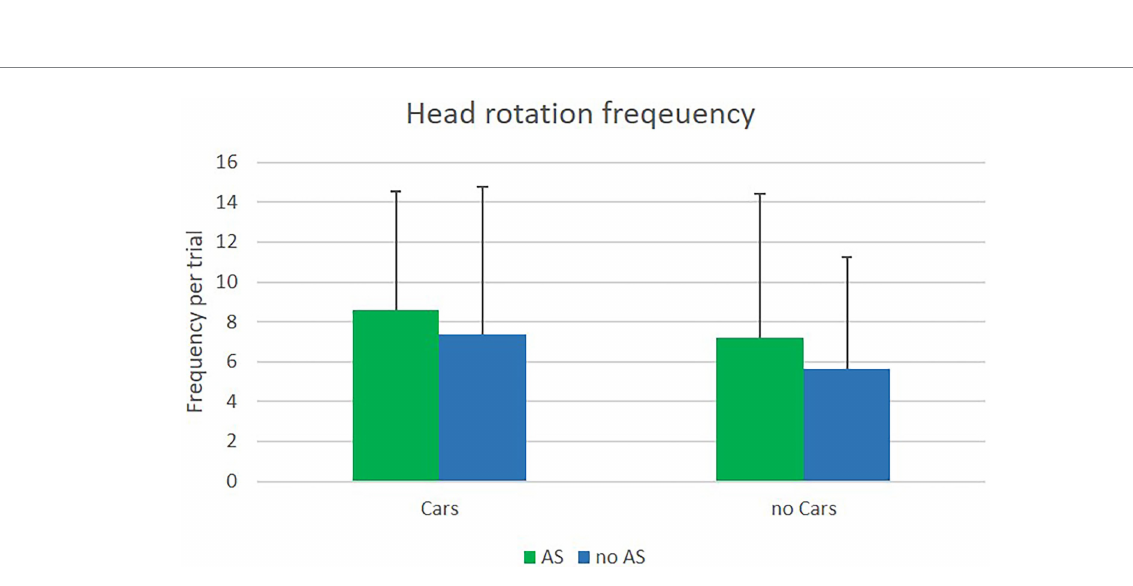
FIGURE 5 Means of head rotation frequencies in the VR experiment with and without cars, with (AS) and without (nAS) the assistance